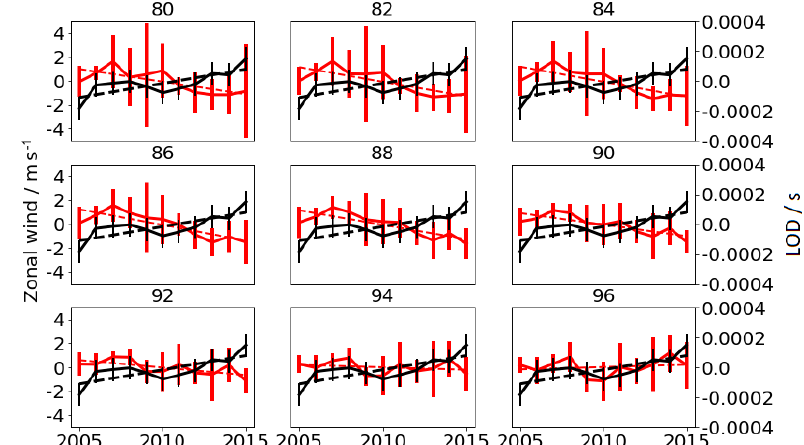
Figure 9. Annual mean values for the LOD (black) and the zonal wind (red), for the station Collm, after removing seasonal variations and the solar cycle for the altitudes between 80 and 100km. The error bars correspond to the standard deviation. The dashed lines represents the tendency.